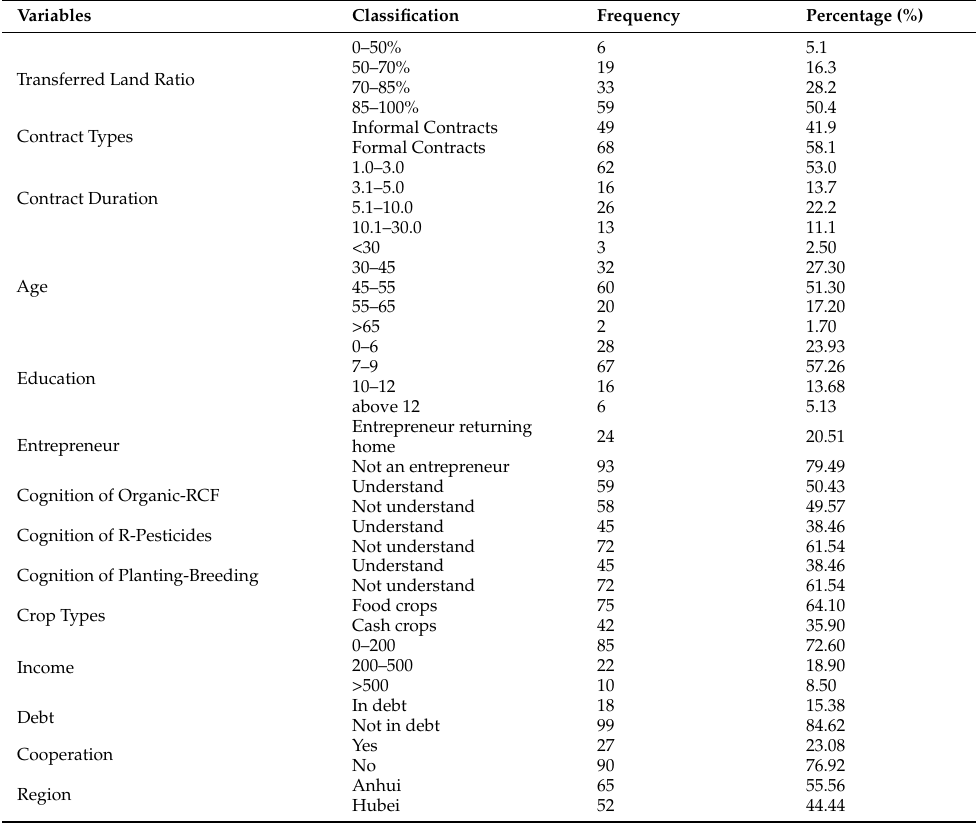
Table 4. Demographic profile of the sample ( n =